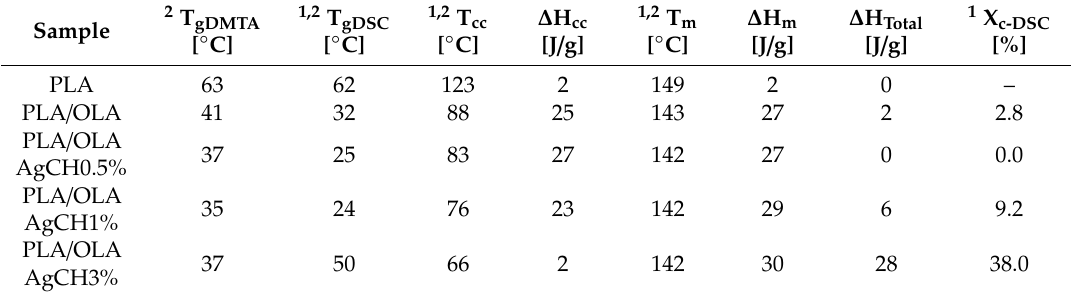
Table 2. Thermal properties and crystallinity calculated from differential scanning calorimetry (DSC) scan for neat PLA and PLA/OLA and nanocomposites formulations containing AgCH-NPs.